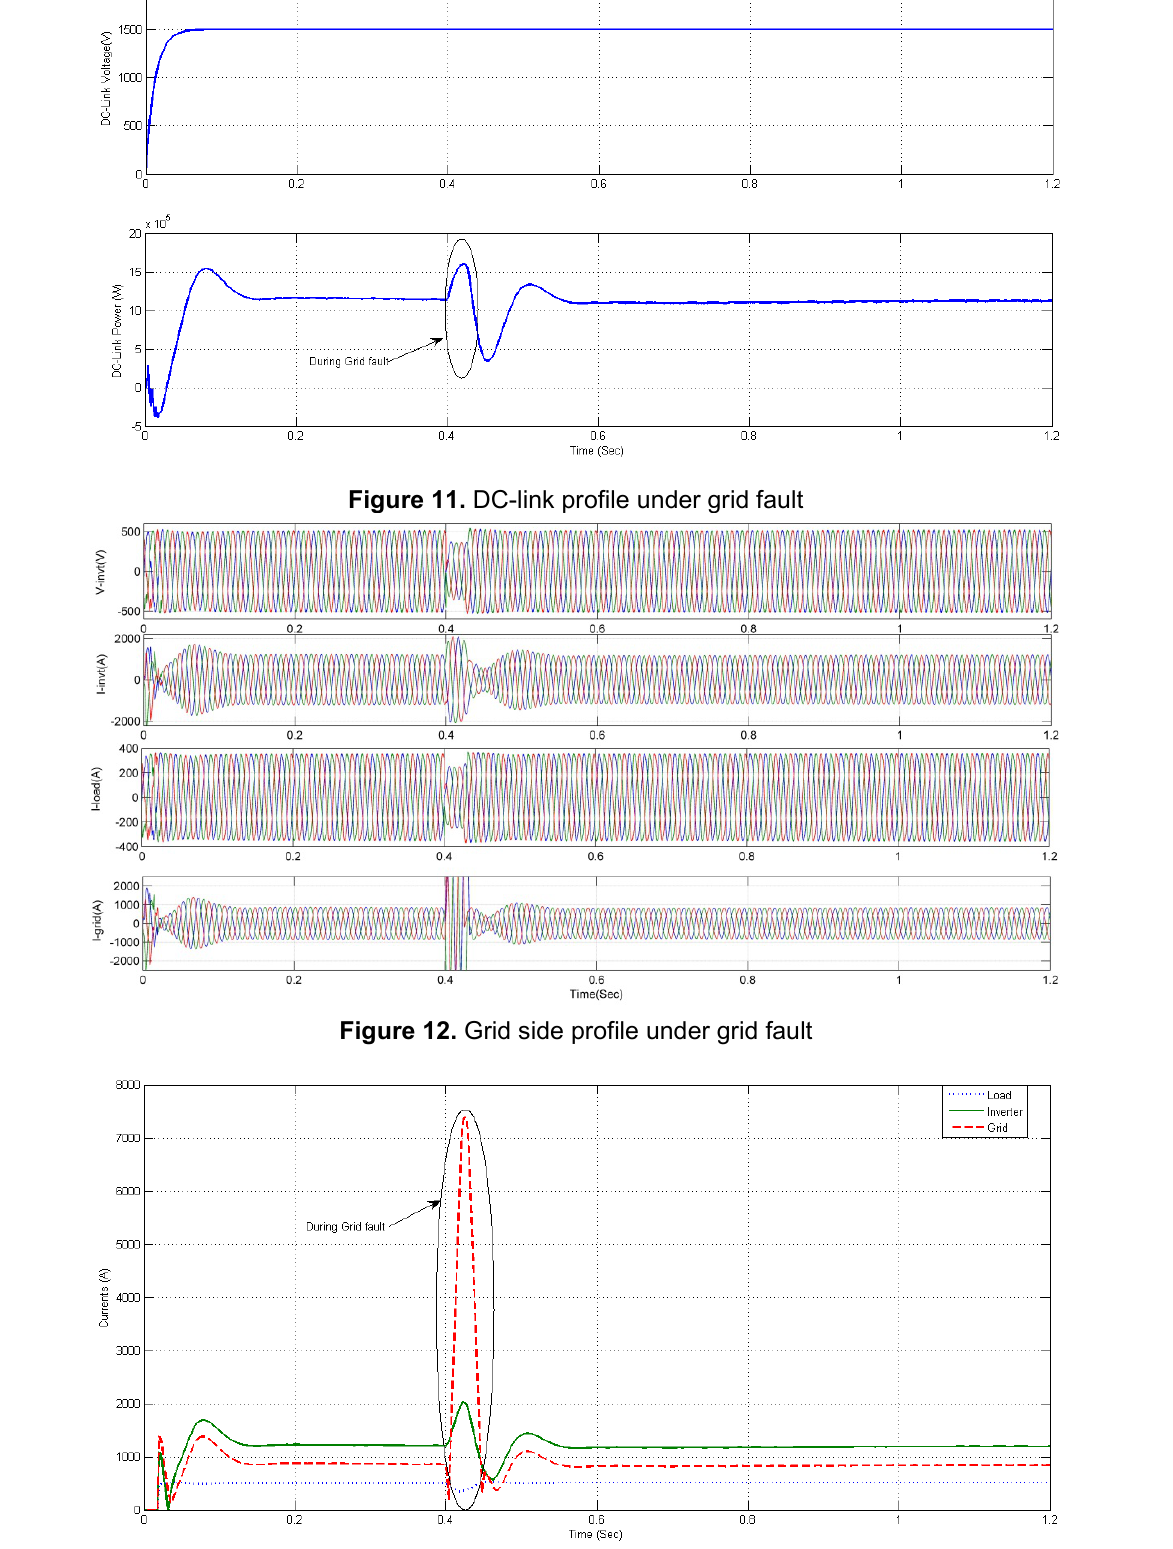
Figure 12. Grid side profile under grid fault